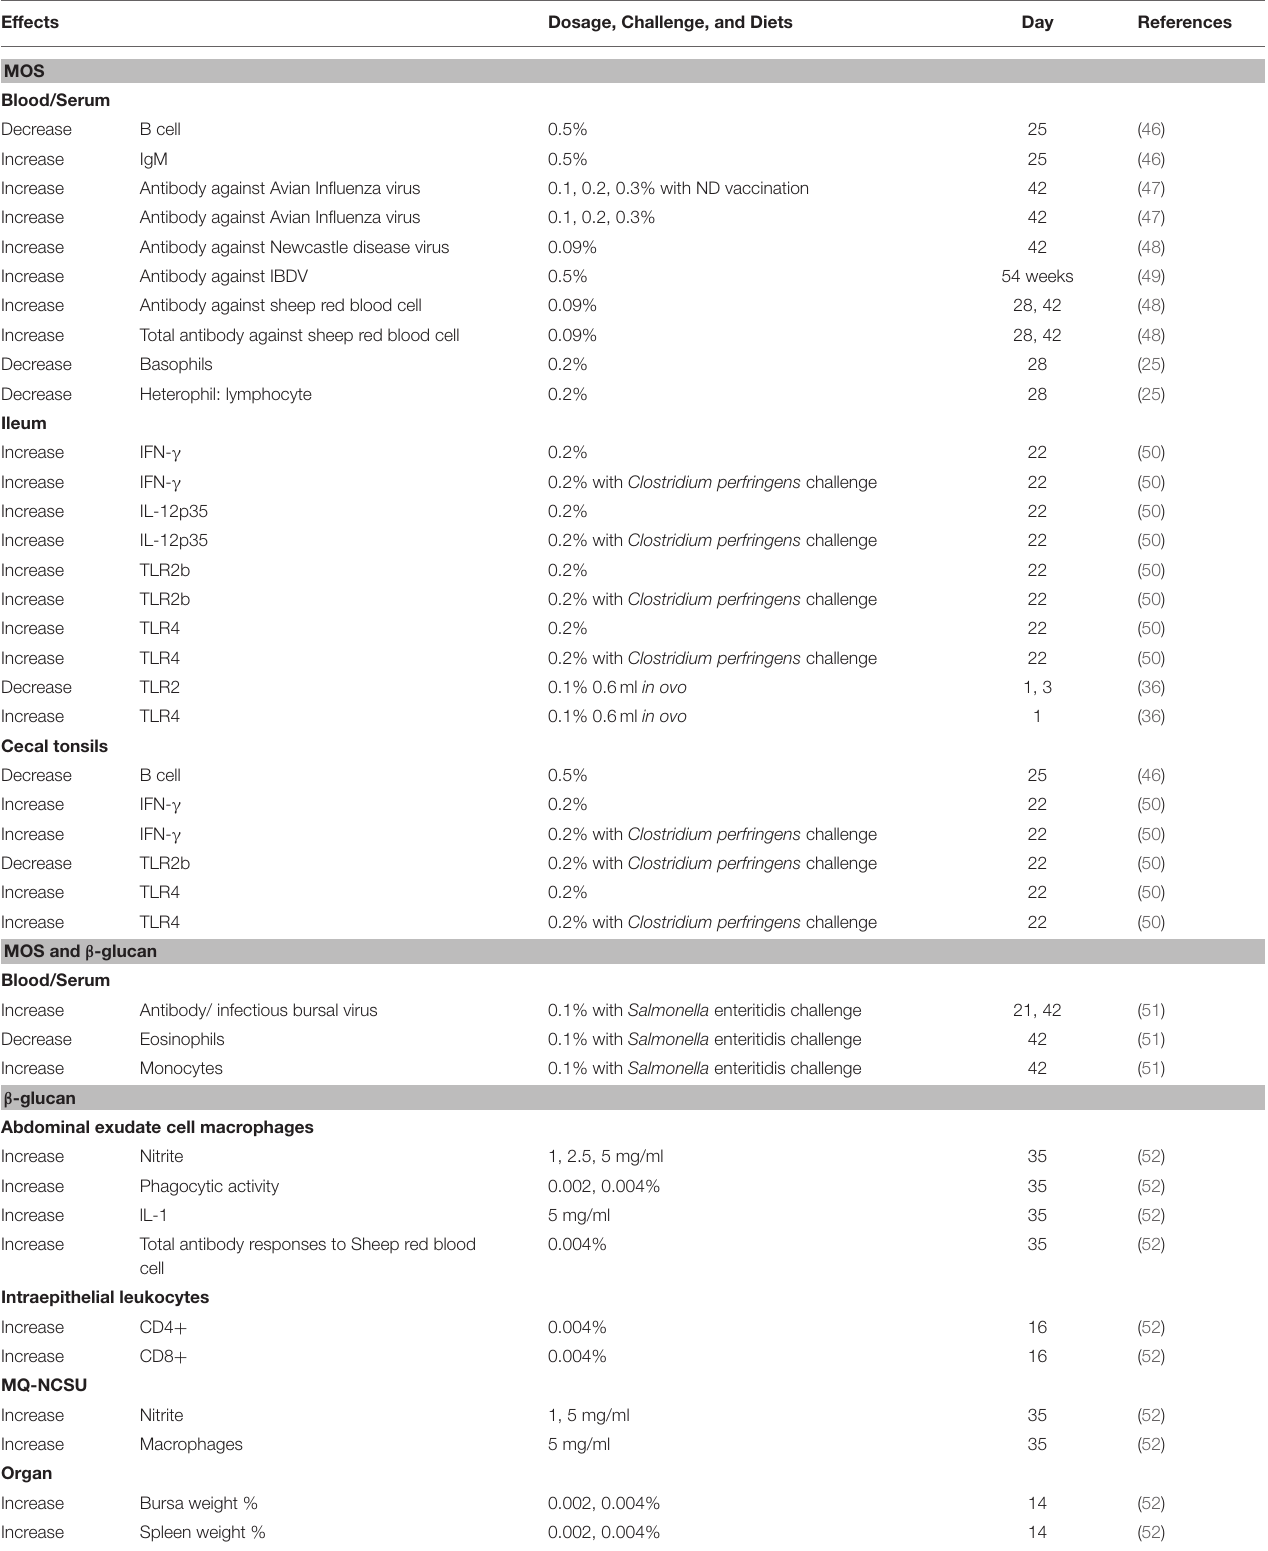
TABLE 3 | Effects of mannan oligosaccharides, β -glucan, and fructans on immune responses of broilers.